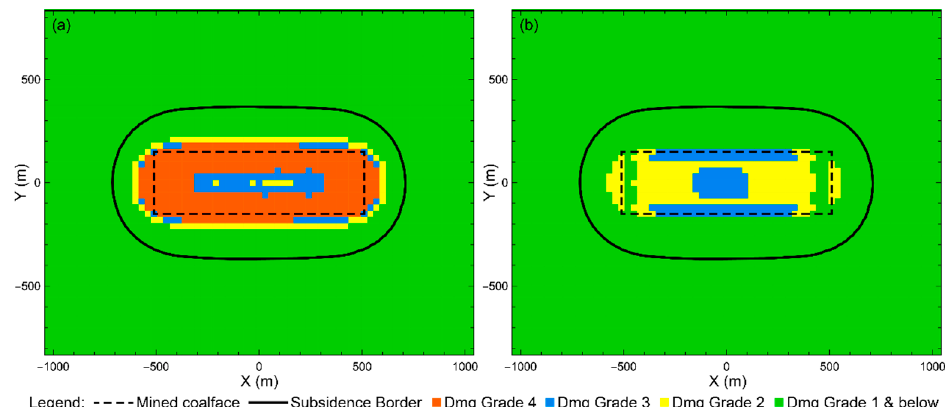
Figure 6. Distribution of ground damage grade for Test 5: based on ( a ) building damage criteria (Table 5) and ( b ) timberland damage criteria (Table 6).